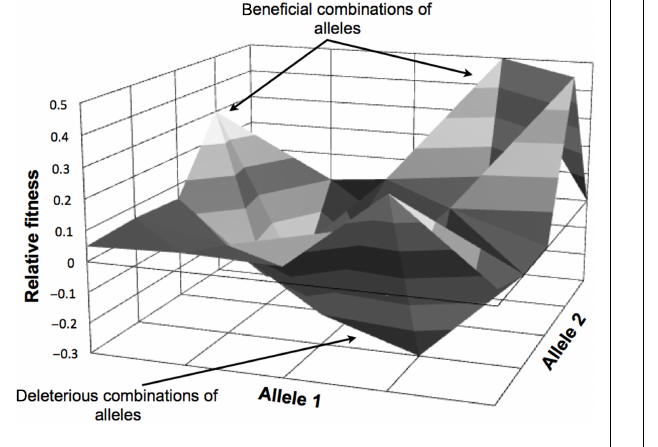
FIGURE 1 | Simplified adaptive landscape for two alleles (for one background genotype in one condition). The figure depicts fitness values for beneficial (positive relative fitness values) and deleterious (negative relative fitness values) combinations of alleles.